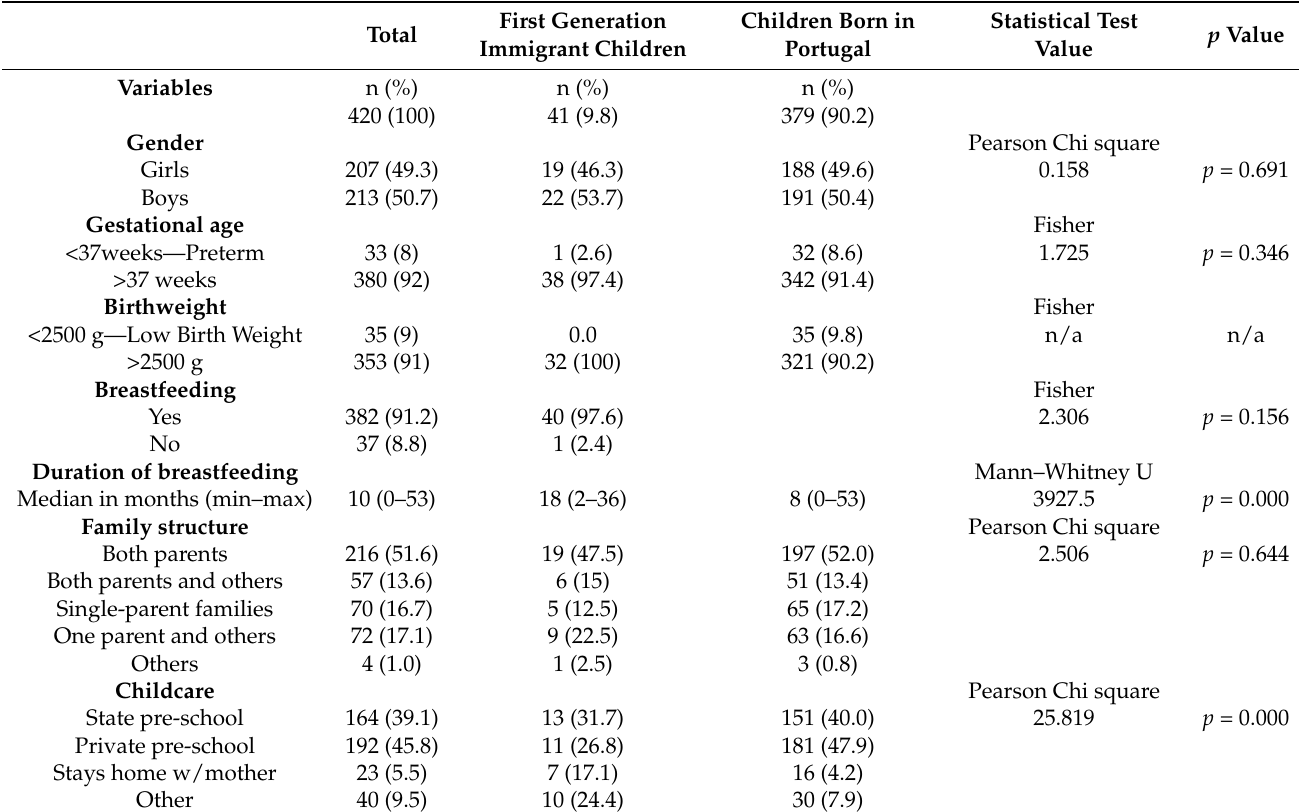
Table 2. Characteristics of the first generation immigrant children versus children born in